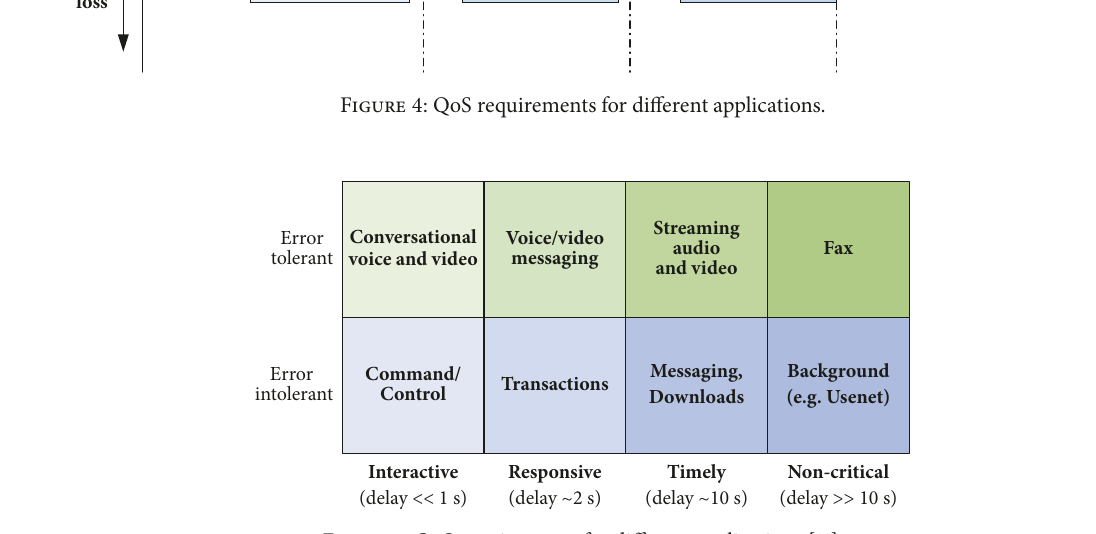
Figure 5: QoS requirements for different applications [11].